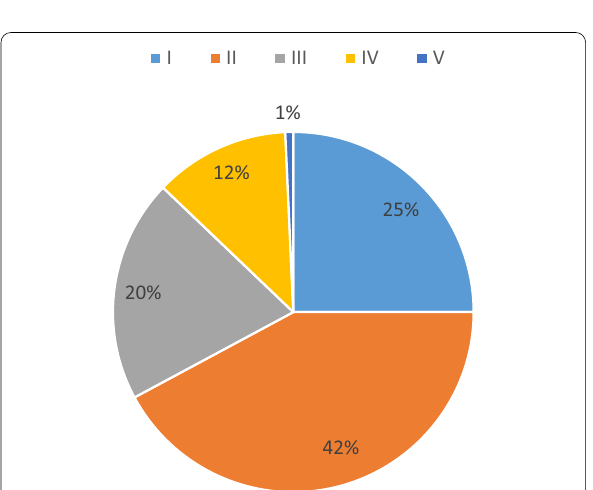
Fig. 7 Species composition in the flora of R. rosea habitats